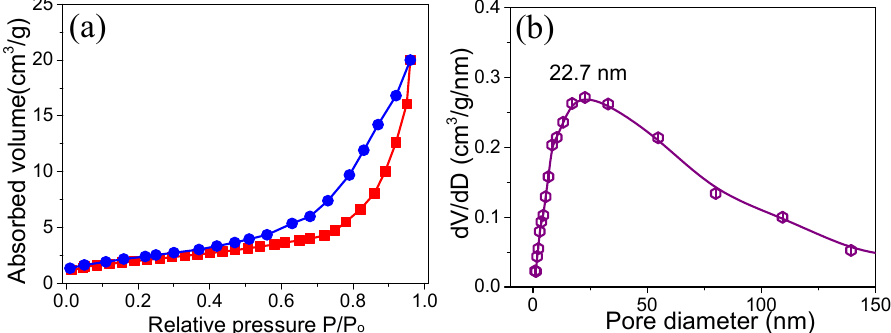
Figure 4. ( a ) Nitrogen adsorption and desorption isotherms and ( b ) BJH pore size distribution curves.